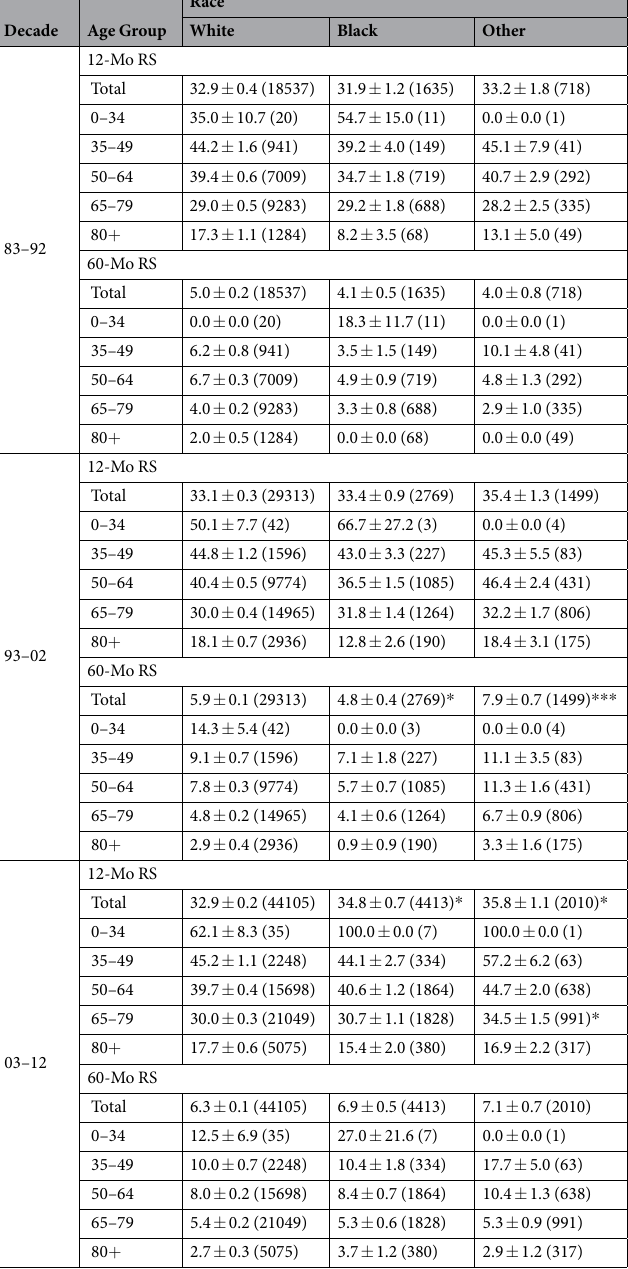
Table 3. 12-month and 60-month relative survival rates of SCLC patients according to race, age group, and calendar period from 1983 to 2012 at 18 SEER sites. Data are means ± standard error of the mean, with number of patients in parentheses. Abbreviations: Mo, month; RS, relative survival; SEM, standard error of the mean. * p < 0.01, ** p < 0.001, and *** p < 0.0001 for comparisons with the White